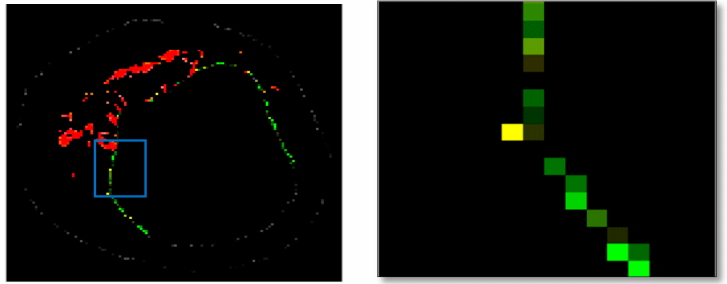
Figure 5. Outliers in an NC image: ( a ) original image, and ( b ) zoomed